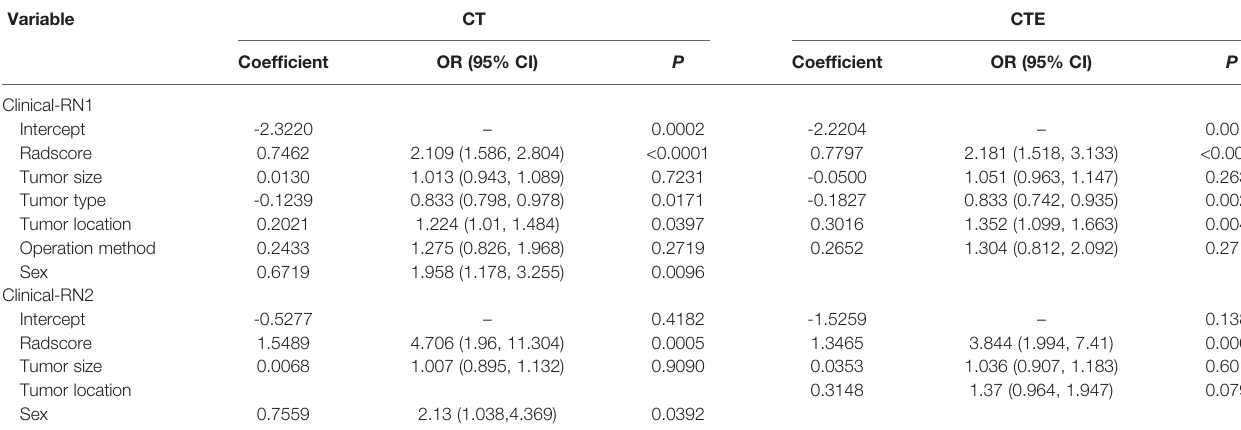
TABLE 3 | Multivariable logistic regression analyses.